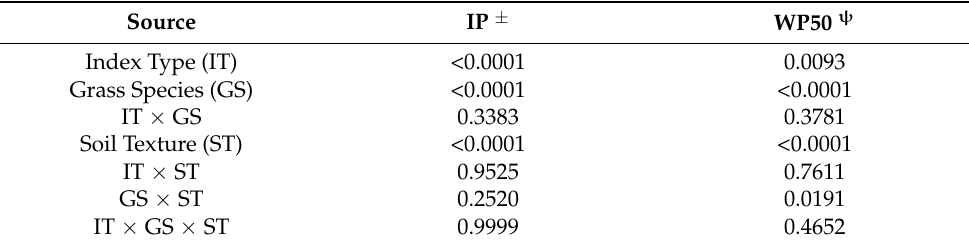
Table 2. Analysis of variance of the inflection points (IP) and hours to reach 50% wilt (WP50) for three vegetation indices based on light reflectance data collected from ‘007’ creeping bentgrass and ‘L-36’ hybrid bermudagrass grown in three soil textures and subjected to drought stress under greenhouse conditions in Blacksburg, VA across six dry-down